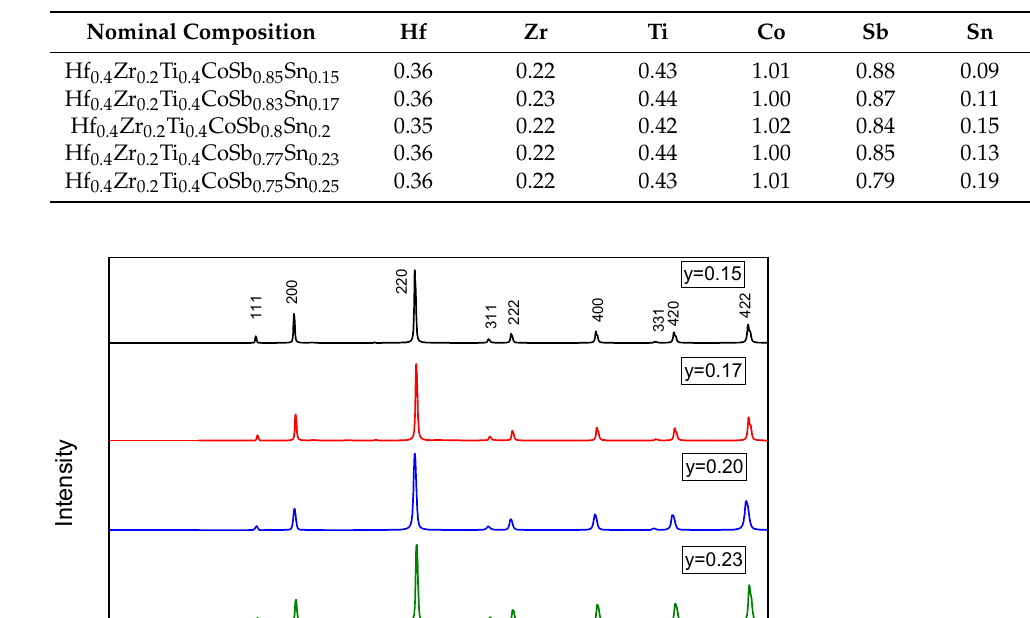
Table 5. Nominal and chemical composition of hot-pressed Hf 0.4 Zr 0.2 Ti 0.4 CoSb 1-y Sn y samples as determined by EDS.